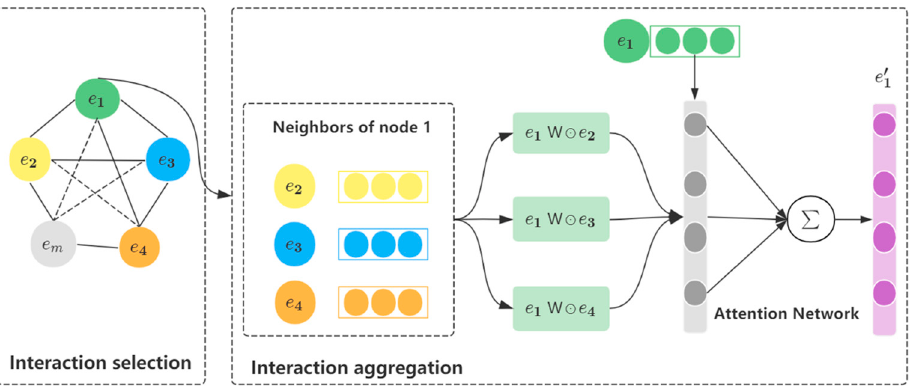
Figure 2. The GNN feature interaction layer.